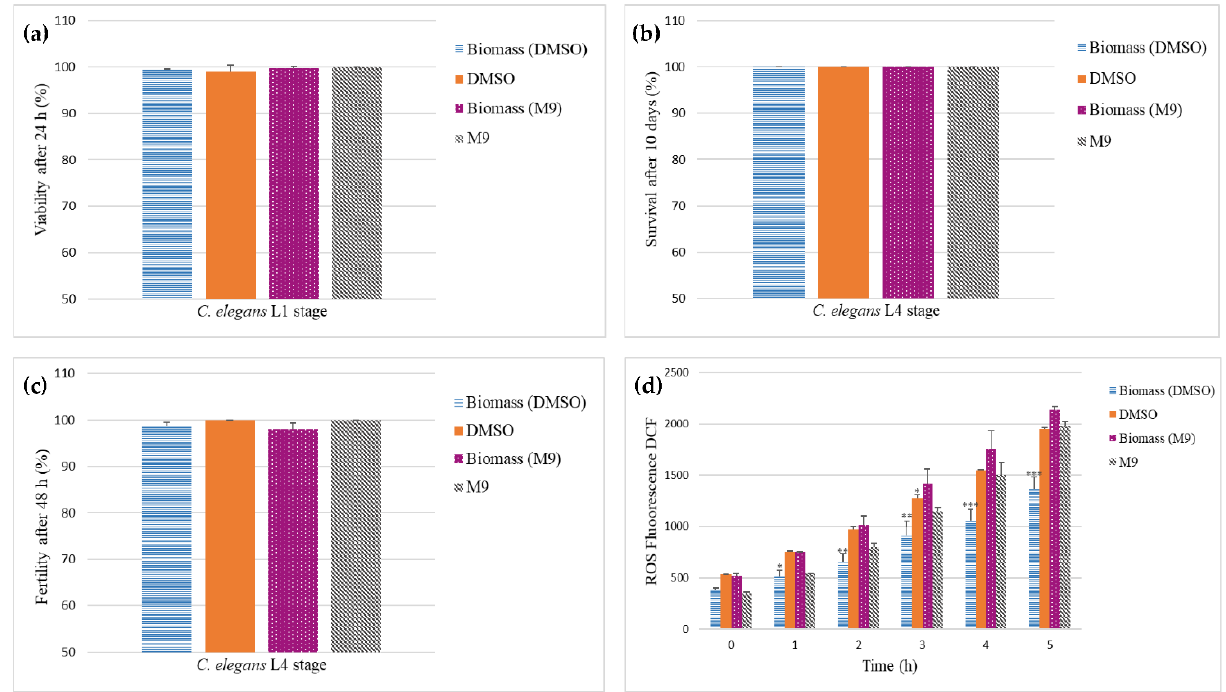
Figure 3. ( a ) Viability of C. elegans L1 stage; ( b , c ) survival and fertility of adult C. elegans L4 stage; ( d ) production of ROS after exposure to a solution of freeze-dried biomass powder (2 µ g/mL in DMSO) and fresh biomass (20 µ g/mL in M9 buffer). Statistical difference: * ( p < 0.05), ** ( p < 0.01), *** ( p < 0.001).